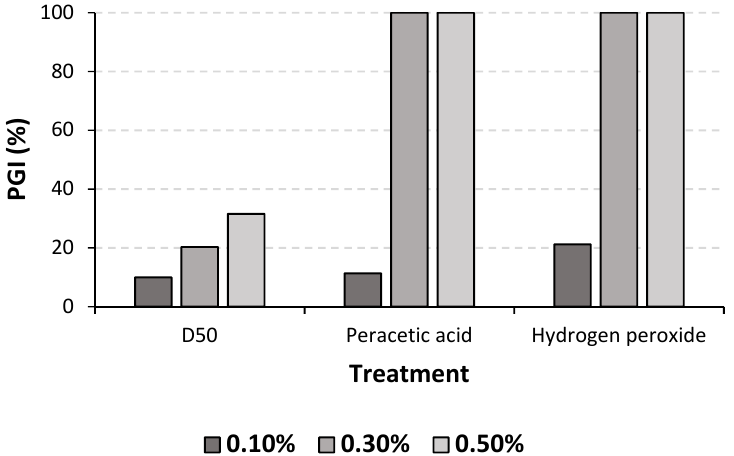
Figure 5. PGI (%) of F. proliferatum in PDA plates with three chemical disinfectants (D50, peracetic acid and hydrogen peroxide) at three concentrations (0.10%, 0.30% and 0.50%). (b) In vivo